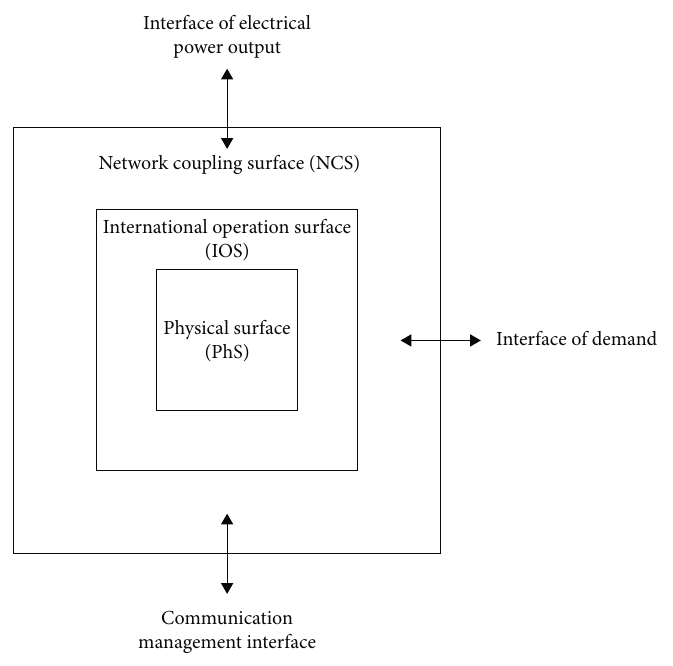
Figure 3: Generic model of ESS. Table 1: EES physical surface modeling for planning of power